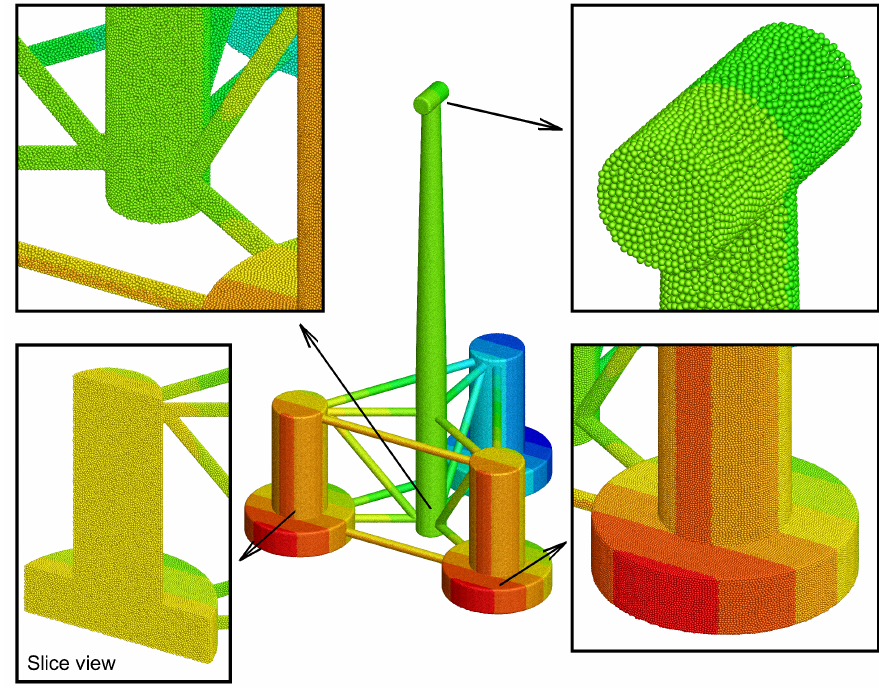
Figure 6. The zoom-in view of the FWT’s particles. The color represents the x -axis position.